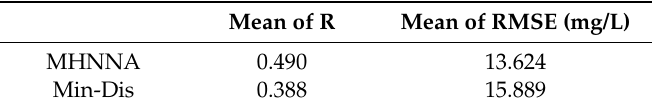
Figure 4. Testing the MHNNA with salt and pepper noise and comparison with the Min-Dis method, as applied, to an ALOS image of TSS concentrations, with accuracy evaluated via a root mean square error (RMSE). Table 8. R and RMSE means of applying MHNNA and Min-Dis methods with noise. Mean of R